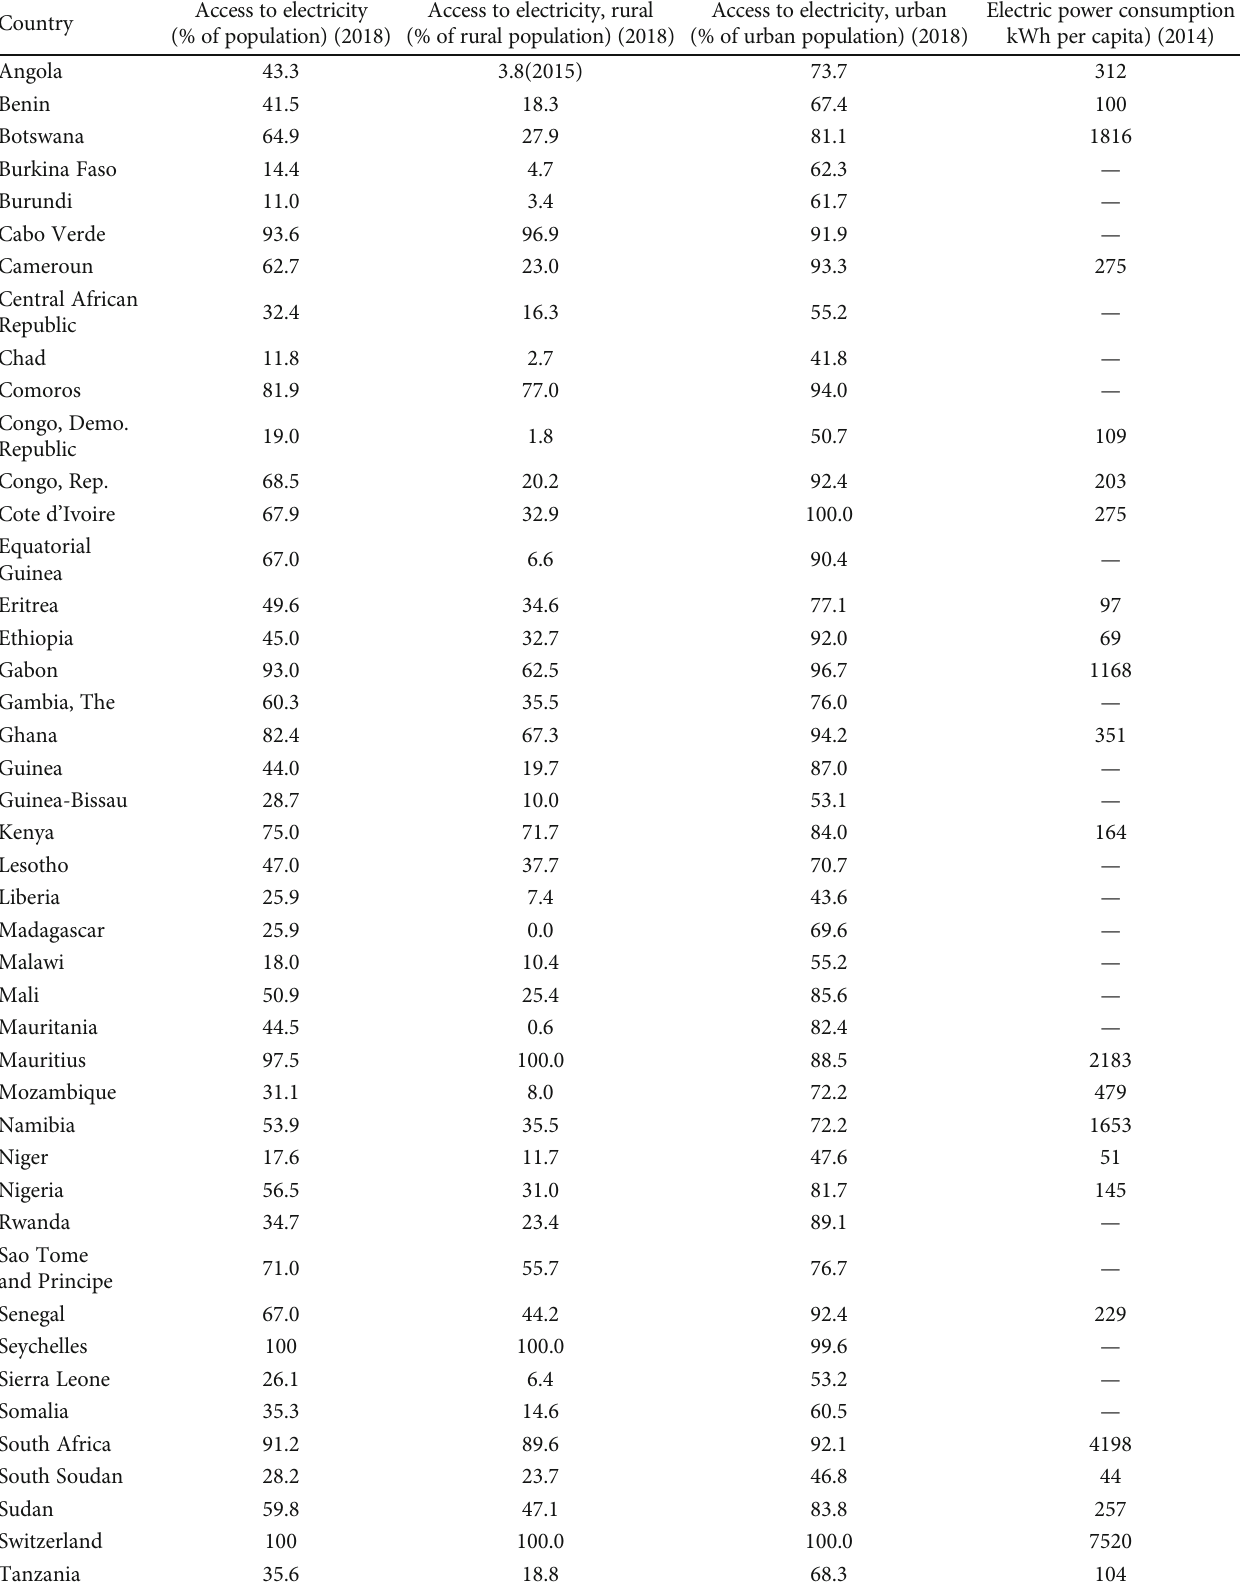
Table 5: Access to electricity in SSA